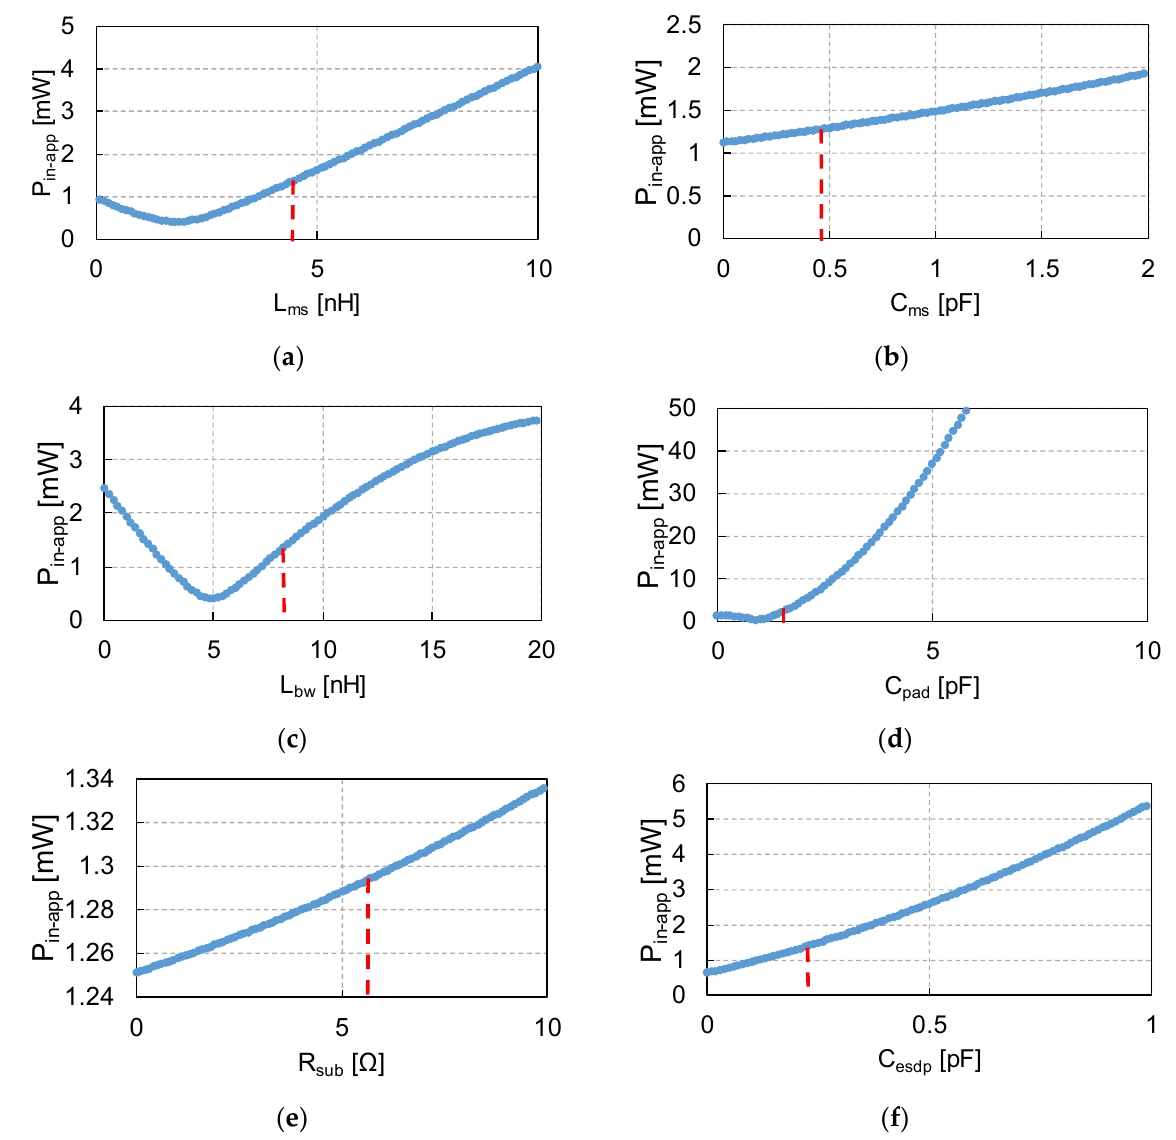
Figure 24.   as a function of each circuit parameter: ( a )   sweep, ( b )   sweep, ( c )   Figure 24. P in − app as a function of each circuit parameter: ( a ) L ms sweep, ( b ) C ms sweep, ( c ) L bw sweep, ( d )   sweep, ( e )   sweep, ( f )   sweep. sweep, ( d ) C pad sweep, ( e ) R sub sweep, ( f ) C esdp